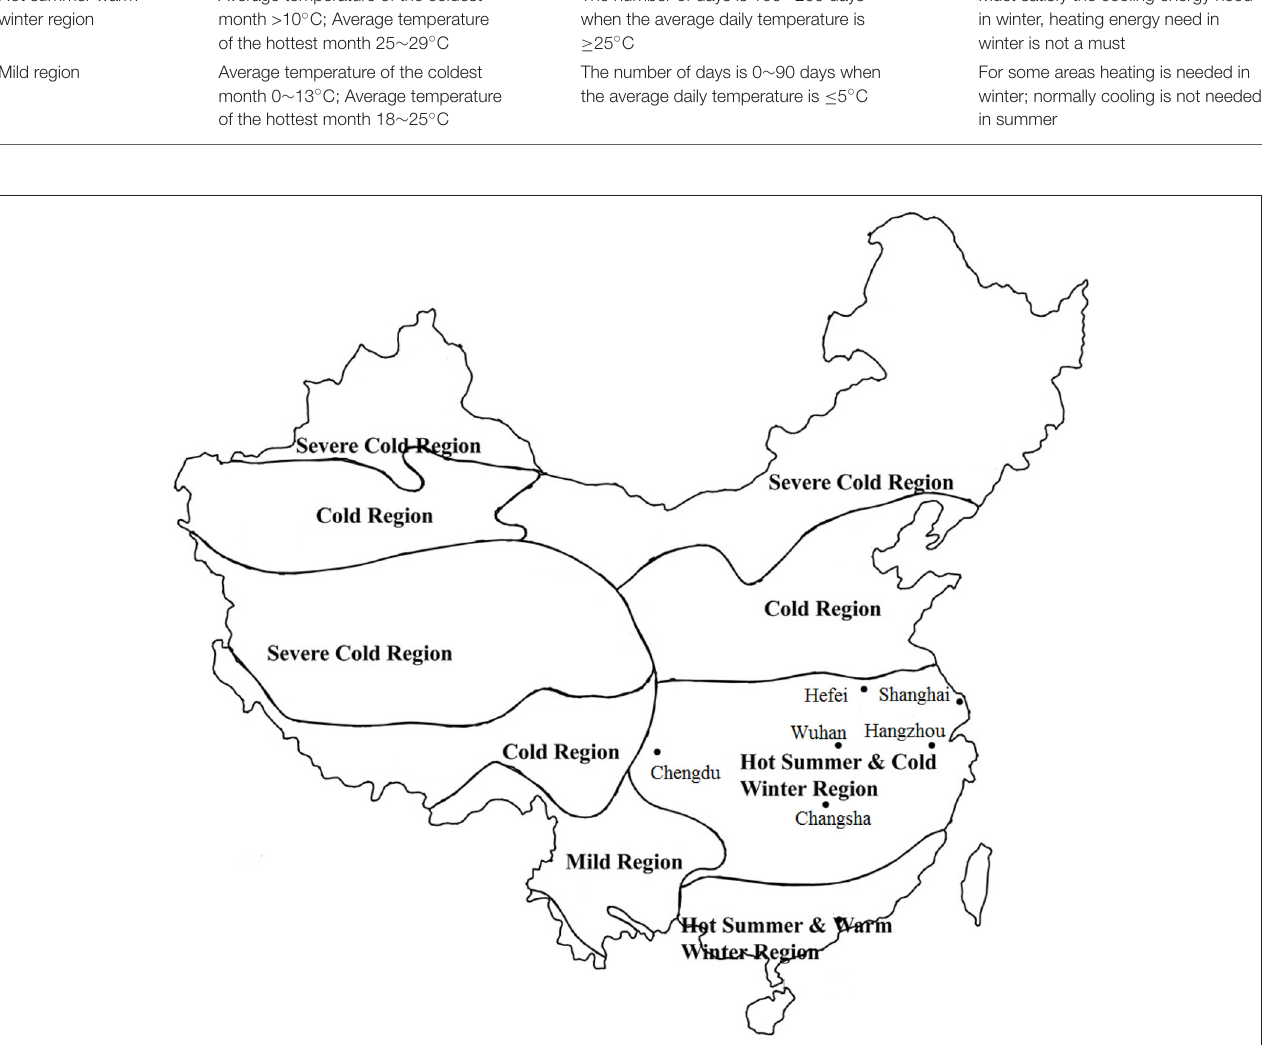
FIGURE 3 | Location of the five selected cities in the hot summer/cold winter region in